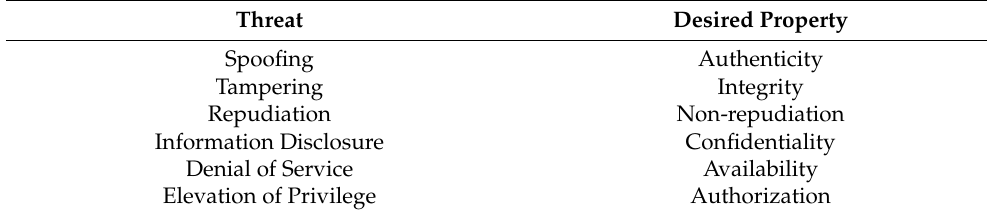
Table 4. Attribute classification according to